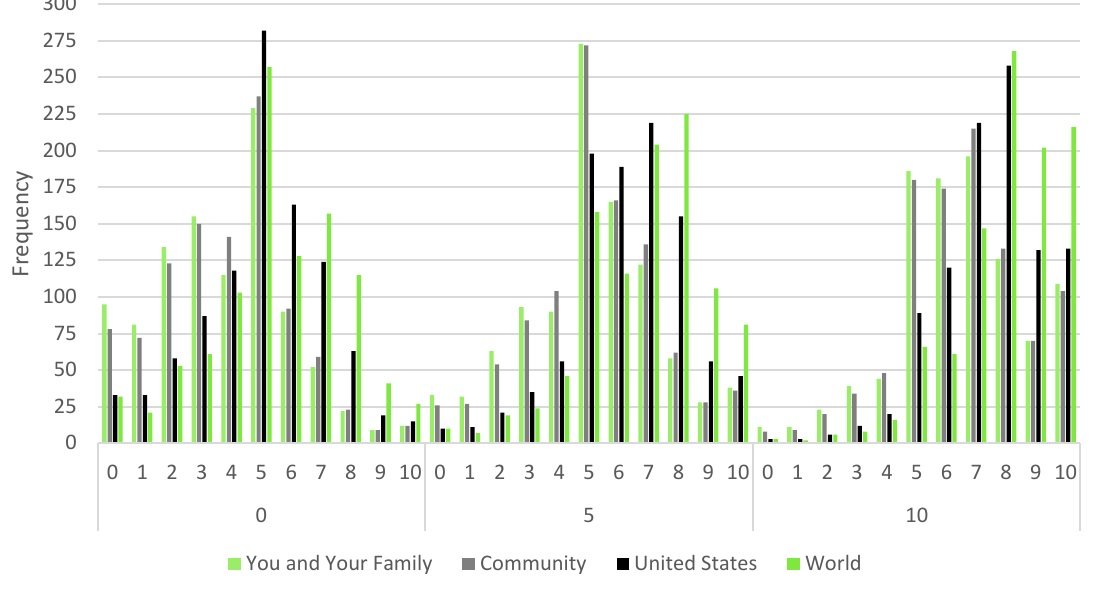
Figure 5. Simulated influence of climate change risk on health risk perceptions in all four